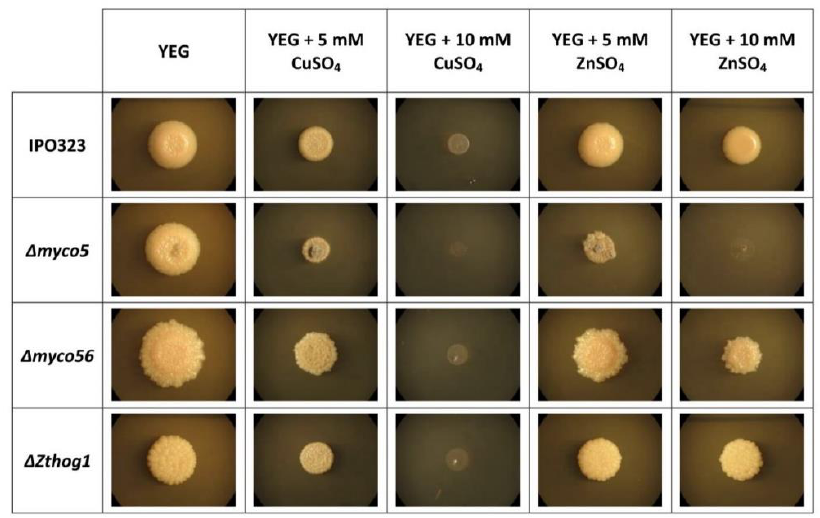
Figure 8. Colony morphology of Zymoseptoria tritici IPO323 and the mutants studied during transient metal stress. ∆ myco5 had increased sensitivity to elevated levels of metal ions. Strains were grown as YEG cultures and then spotted from a spore suspension (1.5 μL; 5 × 10 7 spores/mL) to YEG solid medium supplemented with 5 mM CuSO 4 and 10 mM ZnSO 4 . Plates were imaged following 7 days’ growth at 18 °C.